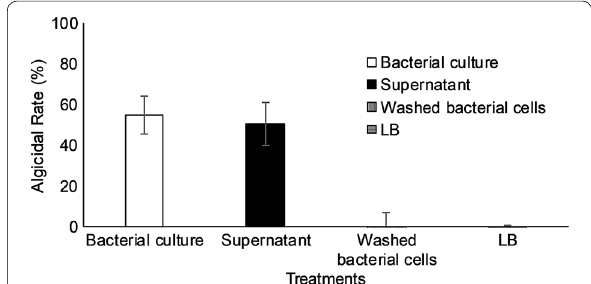
Fig. 1 Evaluation of algicidal mode of JK12. All error bars indicate the SD of the three biological replicates